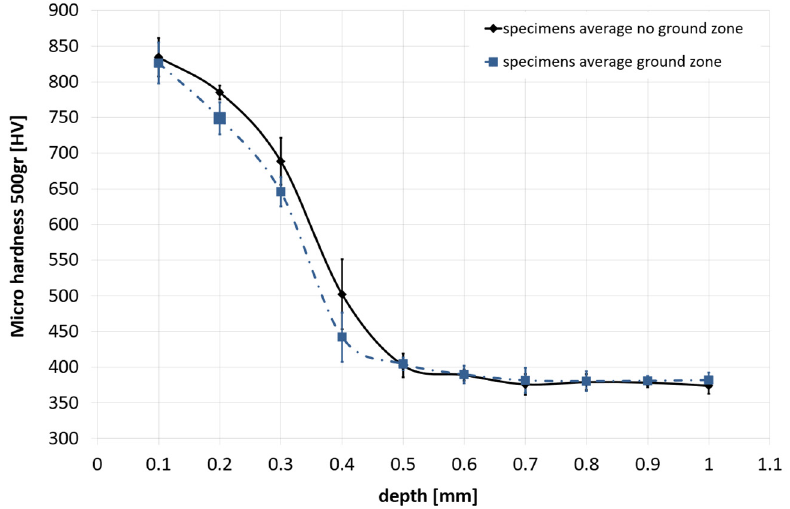
Figure 5. Nitriding depth curves for the ground and polished section (black line) and the not-final ground section (blue dashed